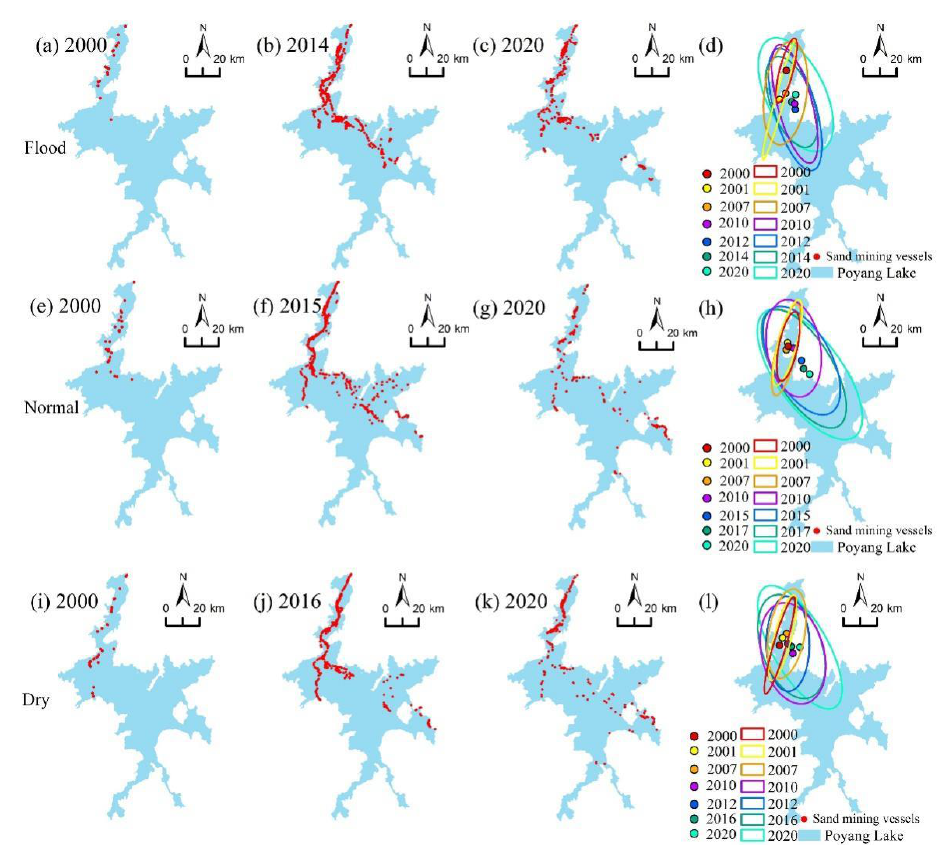
Figure 2. ( a – c ) Distribution of sand mining vessels during the flood season; ( d ) The standard deviation ellipse and mean center in flood season; ( e – g ) Distribution of sand mining vessels during the normal season; ( h ) The standard deviation ellipse and mean center in normal season; ( i – k ) Distribution of sand mining vessels during the dry season; ( l ) The standard deviation ellipse and mean center in the dry season.